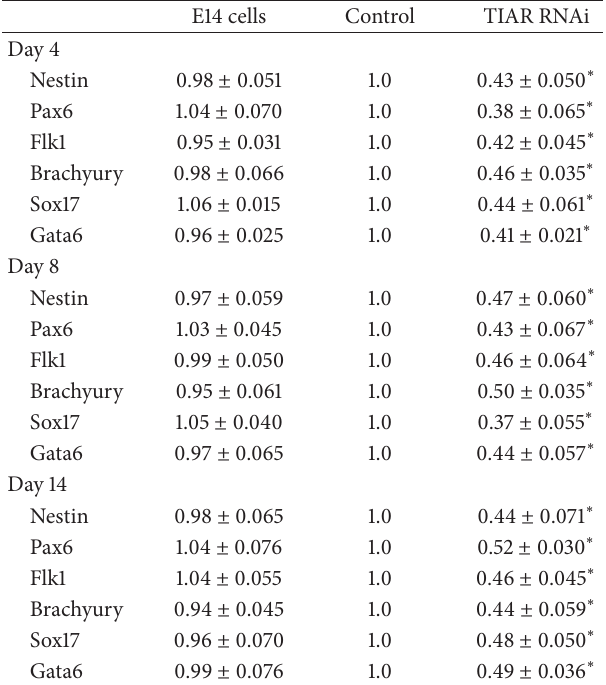
Table 1: Gene expression during EB differentiation in control and TIAR RNAi E14